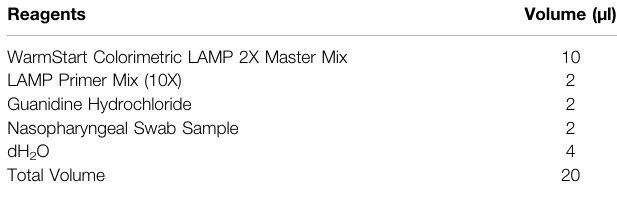
TABLE 2 | Concentrations of each reagent in the RT-LAMP